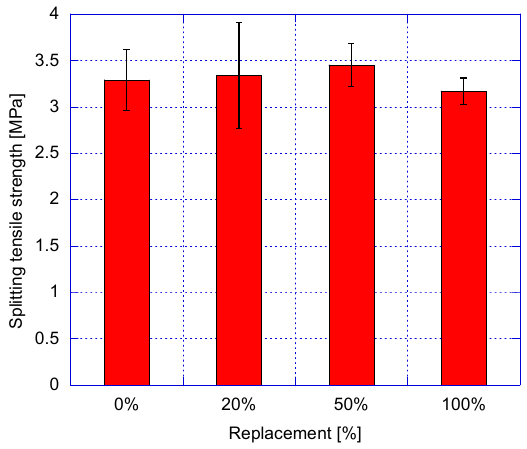
Figure 5. Tensile strength of all mixes at 28 days.